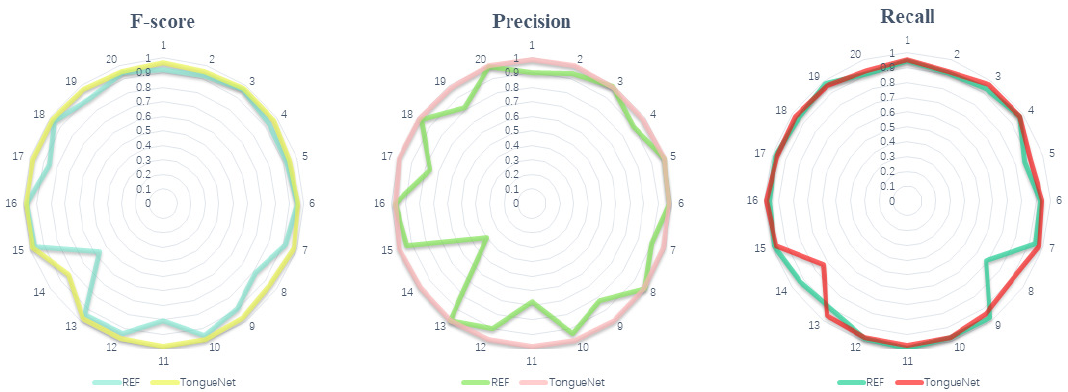
Figure 14. F-score, precision and recall comparison of TongueNet and REF using radar charts. ( left ) F-score; ( center ) precision; ( right )